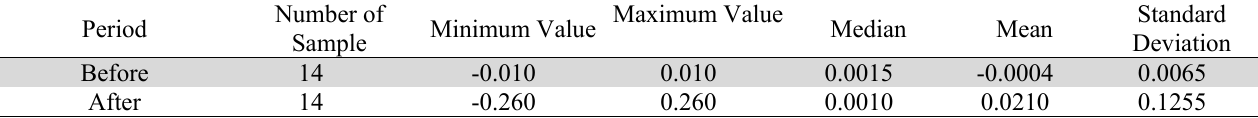
Descriptive Statistics of Profit Response Coefficient for the Periods Before and After PSAK 69 Implementation Number of Period Sample Before